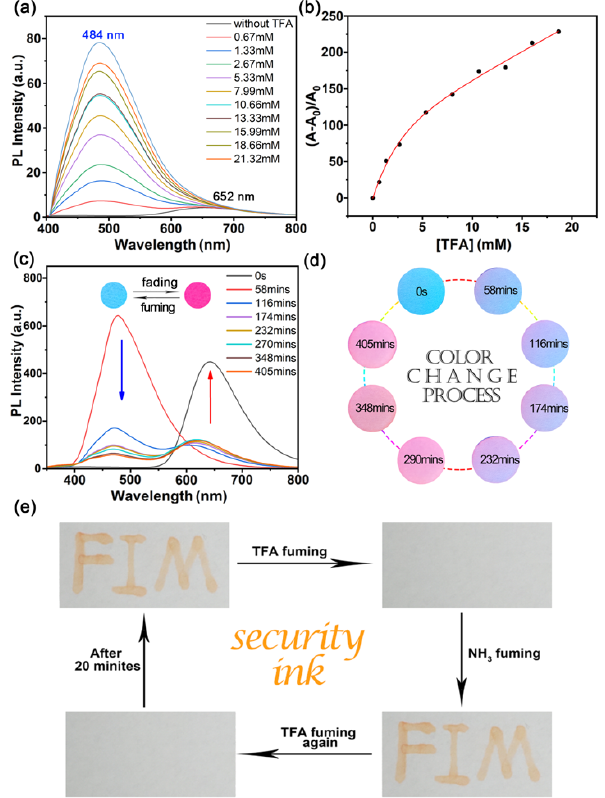
Figure 5. ( a ) Fluorescence spectra of PDB2 (1 × 10 − 4 M) with different concentrations (0.67–21.32 mM) of TFA in the respective solutions of MeOH. ( b ) Fluorescence intensity of PDB2 at 450 nm versus TFA concentration. ( c ) Fluorescence spectra of PDB2 coated on filter paper under a gradual decrease of TFA concentration. ( d ) The color change process of PDB2 filter paper with a gradually decreasing TFA concentration. ( e ) Reversible fluorescence switching by TFA and NH 3 exposure ( λ ex = 365 nm). Inset: Photographs of circular paper sheets treated with dichloromethane PDB2 solution and circular paper sheets after TFA fuming with 365 nm UV light.